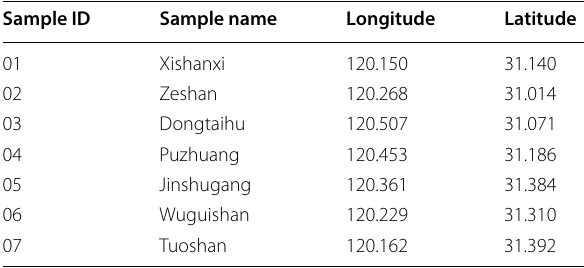
Table 1 Geographical features of sampling sites